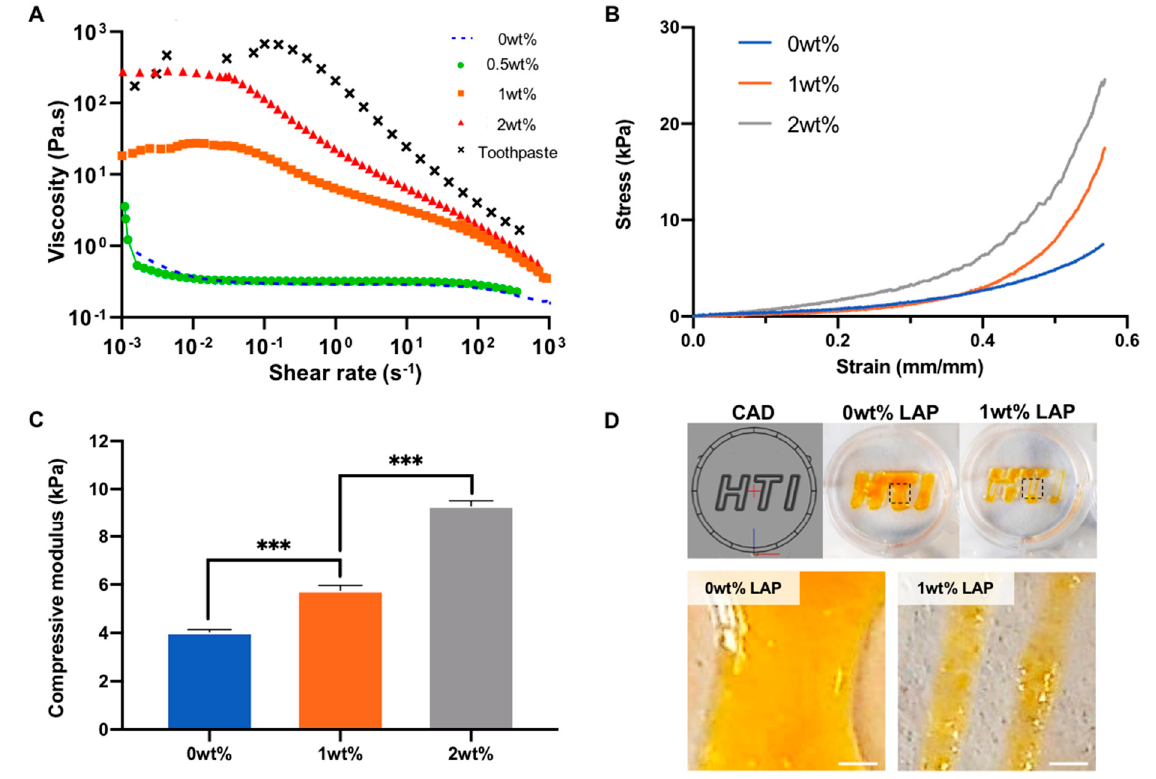
Figure 2. The physicochemical properties of GelMA-LAP hydrogel. ( A ) Viscosity shear rate of pre-polymer solution (GelMA and GelMA loaded with nanosilicates) highlights shear-thinning characteristic of the pre-polymer solution loaded with LAP. ( B , C ) Nanocomposite hydrogels were subjected to unconfined compression. From the stress strain curves, the compressive modulus of the hydrogels was calculated from the 0.10–0.20 strain. ( D ) GelMA bioinks were 3D printed to evaluate shape fidelity of printed structures. Scale bar = 1 mm. Data are expressed as mean ± SD ( n = 3). *** p ≤ 0.001.